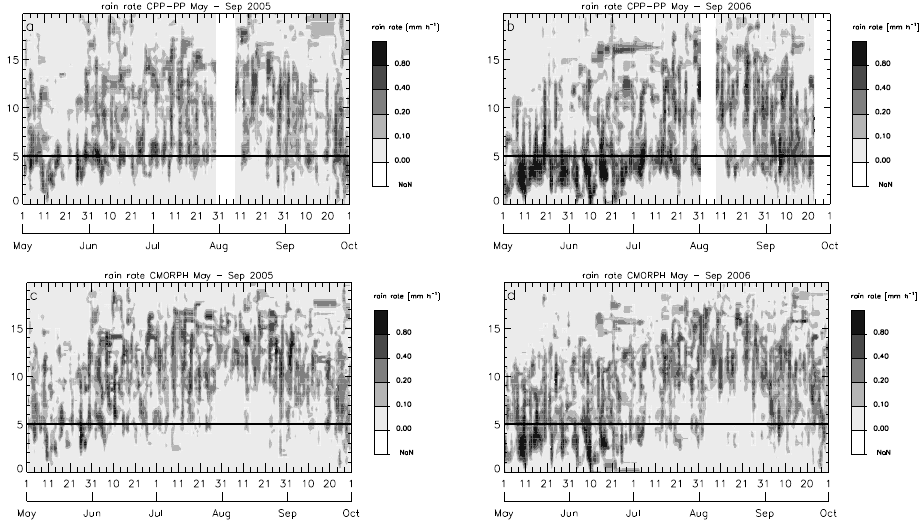
Fig. 6. Hovm¨uller plots of (left) 2005 and (right) 2006 daytime conditional rain rate ( R> 0.05mmh − 1 ) for 0 ◦ –20 ◦ N; (top) CPP-PP and (bottom) CMORPH. Both datasets are at 0.25 ◦ × 0.25 ◦ resolution. Values have been averaged over 10 ◦ W–10 ◦ E. The thick horizontal line denotes the approximate location of the coastline. The white bands in the CPP-PP plots indicate data archive gaps.